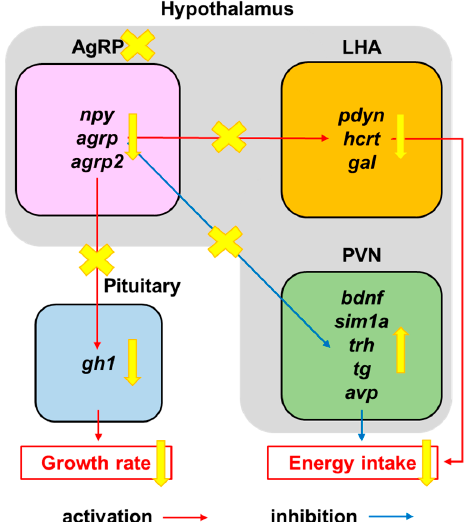
Figure 8. Appetite-regulation pathway under AgRP neuron ablation. Schematic diagram of sup- pression of orexigenic factors ( pdyn , hcrt , and gal ) within the lateral hypothalamus area (LHA) and promotion of anorexigenic factors ( bdnf , sim1a , trh , tg , and avp ) within the paraventricular nucleus (PVN) via AgRP neuron ablation, leading to appetite and growth suppression.